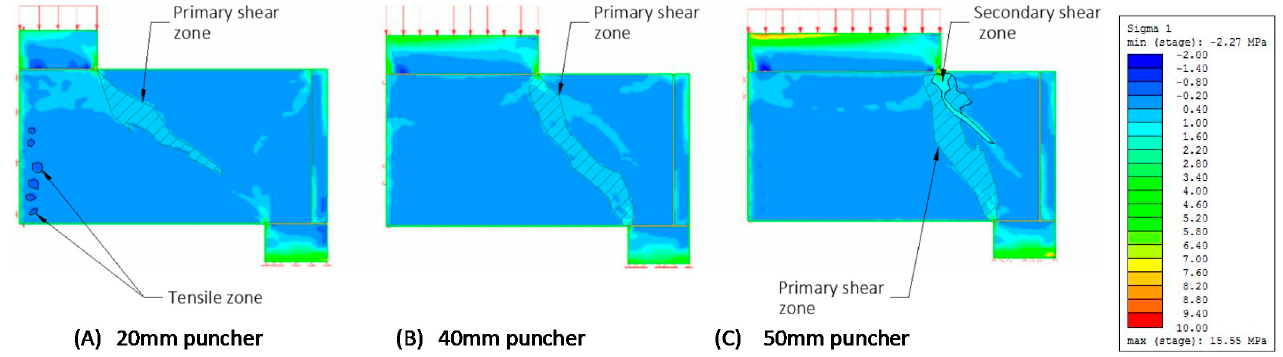
Figure 7. Punching shear numerical simulation.